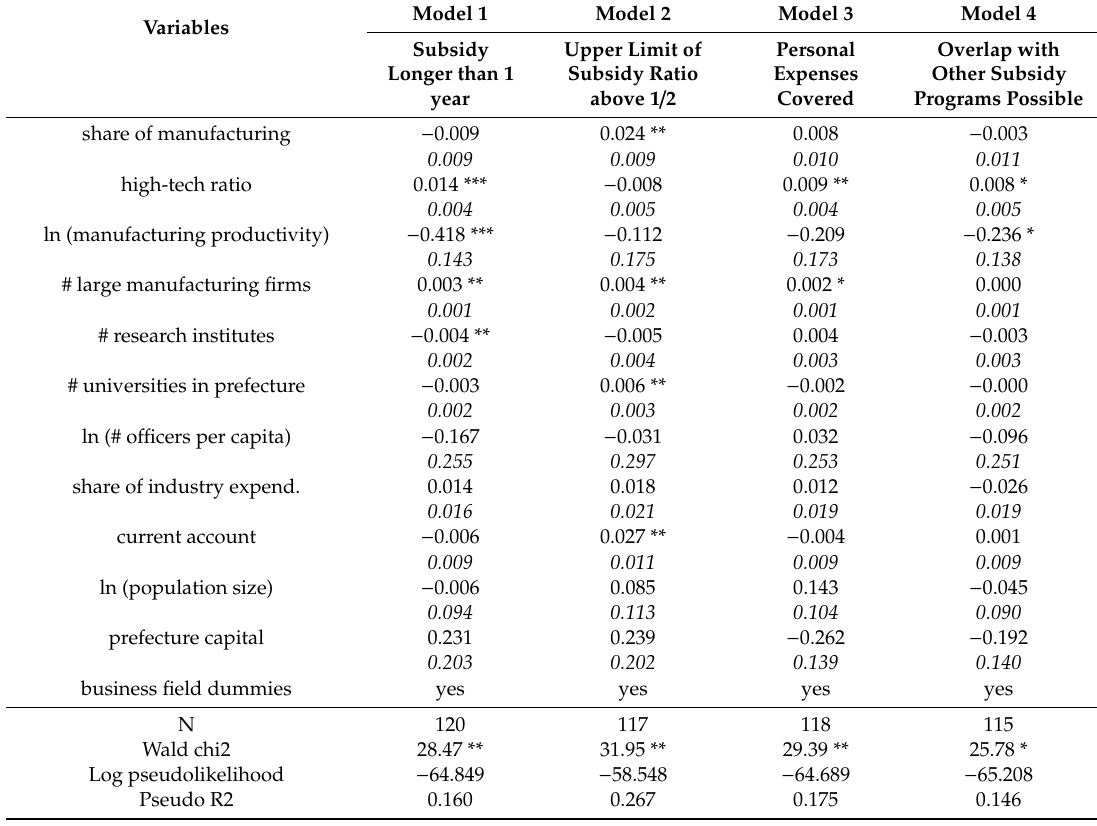
Table 6. Estimation results on the design of R&D subsidy